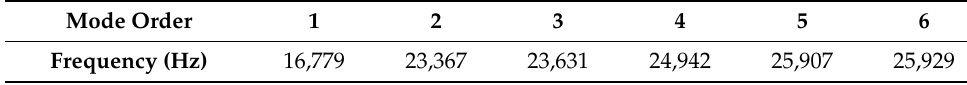
Table 1. The natural frequencies of the first six-order